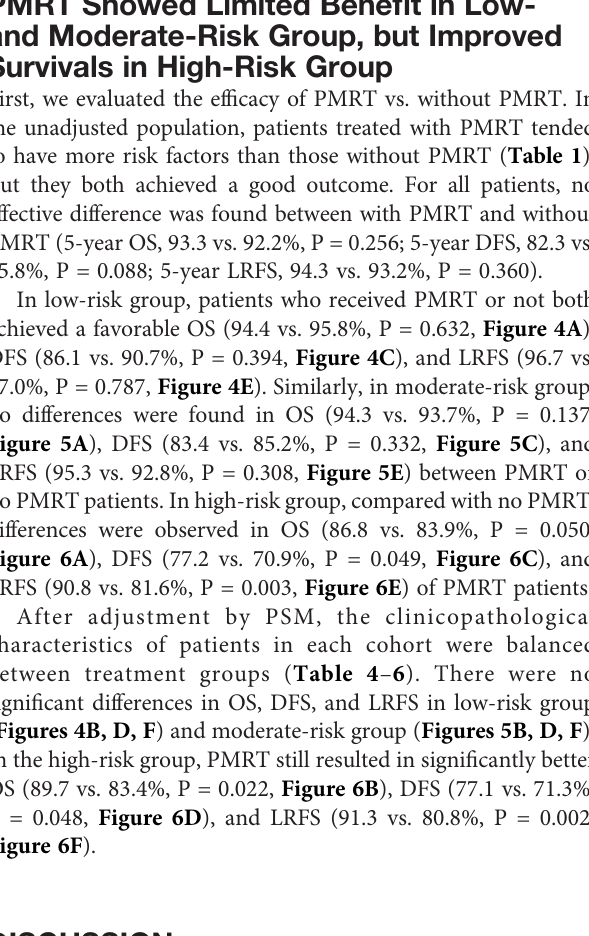
Figure 6A ), DFS (77.2 vs. 70.9%, P = 0.049, Figure 6C ), and LRFS (90.8 vs. 81.6%, P = 0.003, Figure 6E ) of PMRT patients.